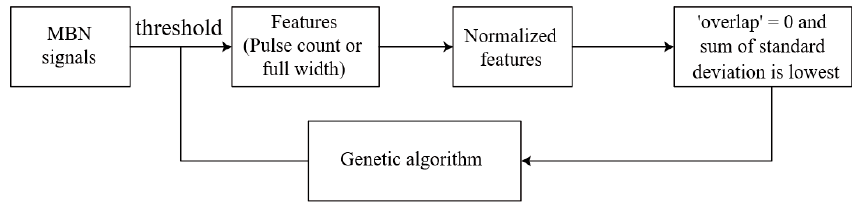
Figure 7. Flowchart of adaptive threshold selection based on genetic algorithm.